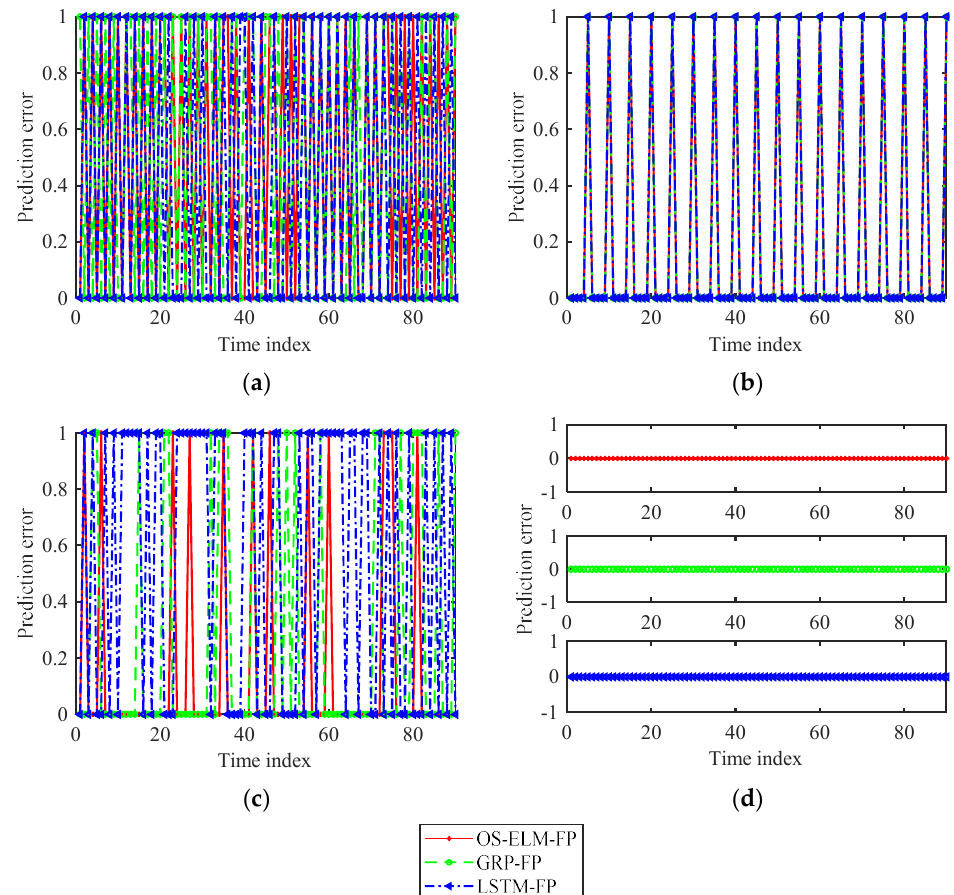
Figure 10. Online continuous multi-time frequency prediction results for the ( a ) Markov, ( b ) triangular